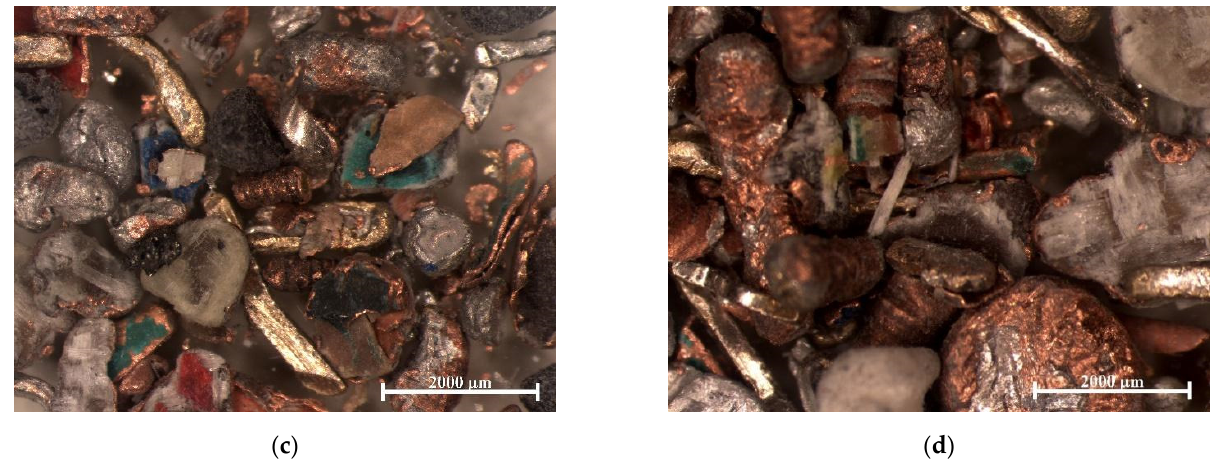
Figure 4. Concentrate from electrostatic separation (stereo microscope): ( a ) option 1, ( b ) option 2, ( c ) option 3, and ( d ) option 4.